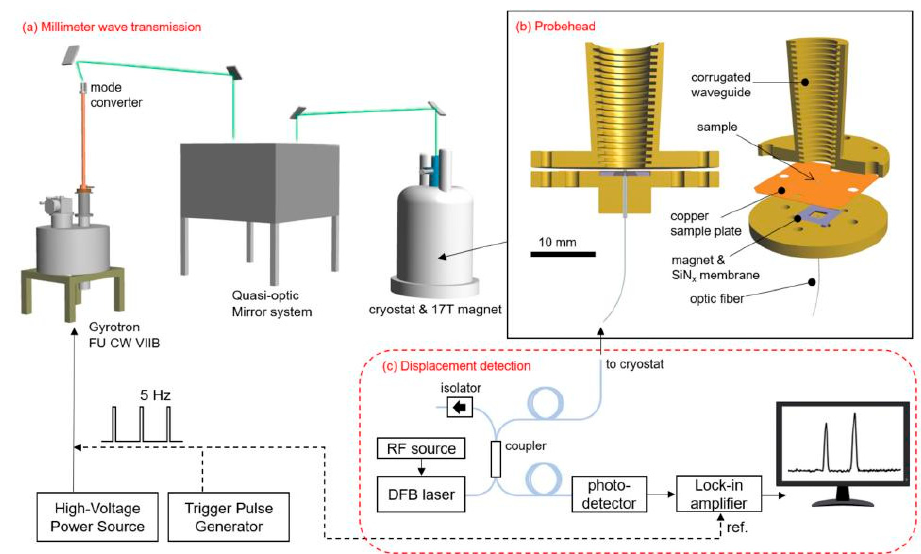
Figure 3. ( a ) Schematic of the gyrotron FDESR system. ( b ) Cross-sectional view of the FDESR probe head and part configuration. ( c ) Setup of optical interferometry for the displacement detection of the nanomembrane. Reprinted with permission of AIP Publishing from Ref. [54].